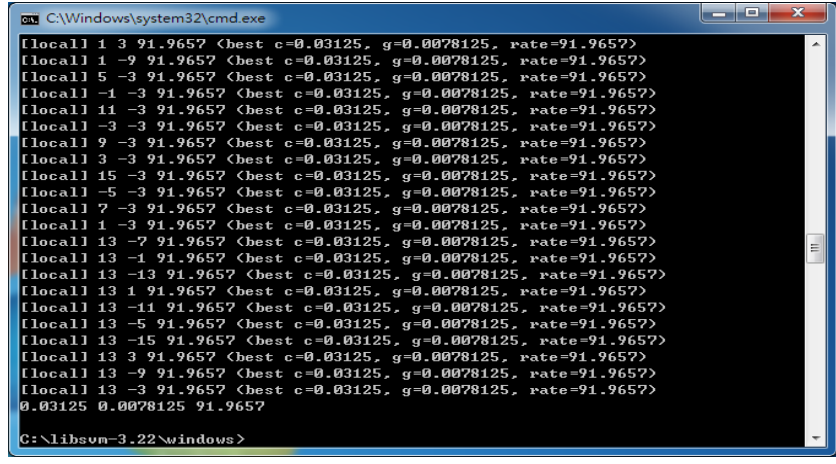
Figure 2. Optimal parameters c and g.